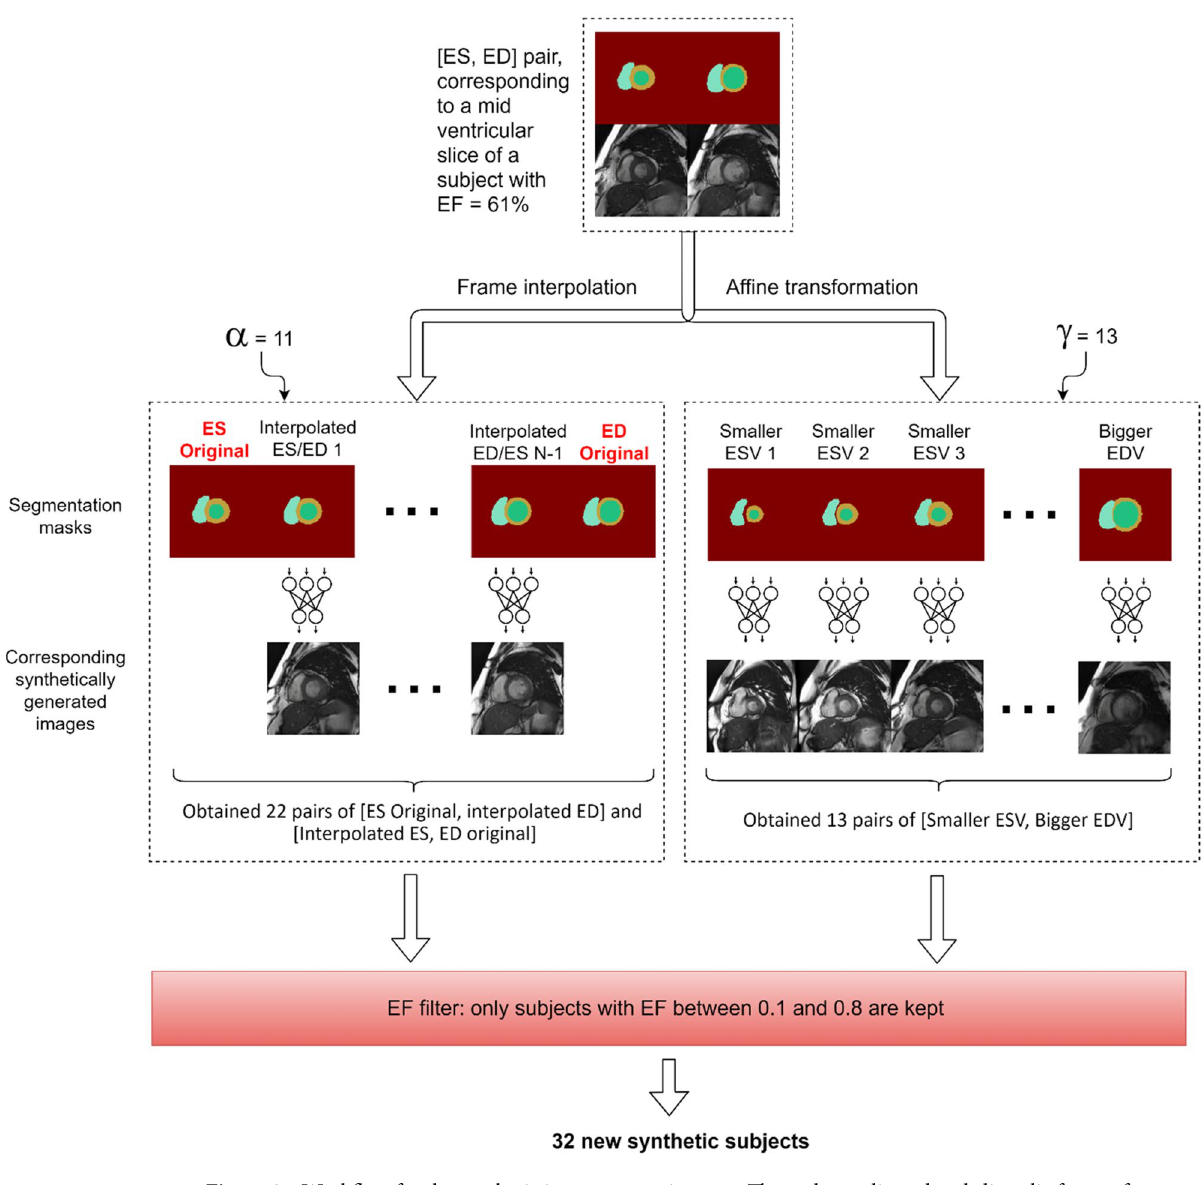
Figure 2. Workflow for the synthetic image generation step. The end-systolic and end-diastolic frames from every slice of the training data goes through this process to generate an extended set of masks with different EF values. Parameters α and γ are used to control the number of interpolated frames between [ES, ED], and the number of rescaled [ES, ED] pairs. In order to generate a new synthetic slice (ed, es pair) with smaller EF, new pairs of [ES original, Interpolated ED] and [Interpolated ES, ED original] are chosen. To generate a new synthetic slice with higher EF, a pair of [Smaller ESV, Bigger EDV] is chosen. An additional step is employed to filter only resulting subjects with EF between 10 and